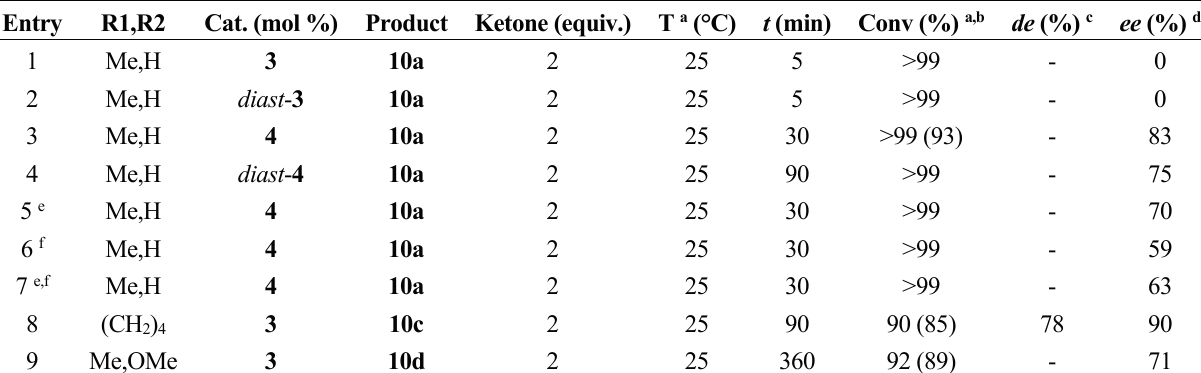
Table 2. Optimization of reaction conditions.